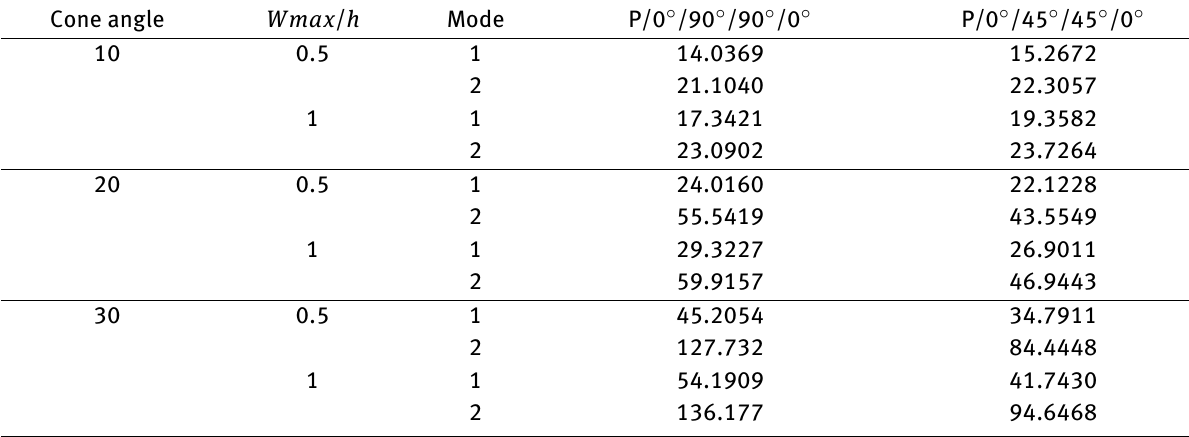
Table 10: Effect of cone angle, amplitude ratio, frequency mode and stacking sequence on dimensionless mean nonlinear natural frequency of conical shell panel.